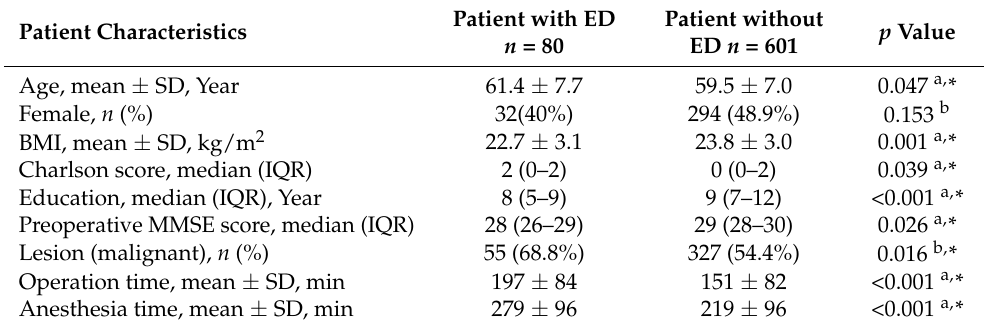
Table 2. Prevalence, risk factors and clinical characteristics of ED.